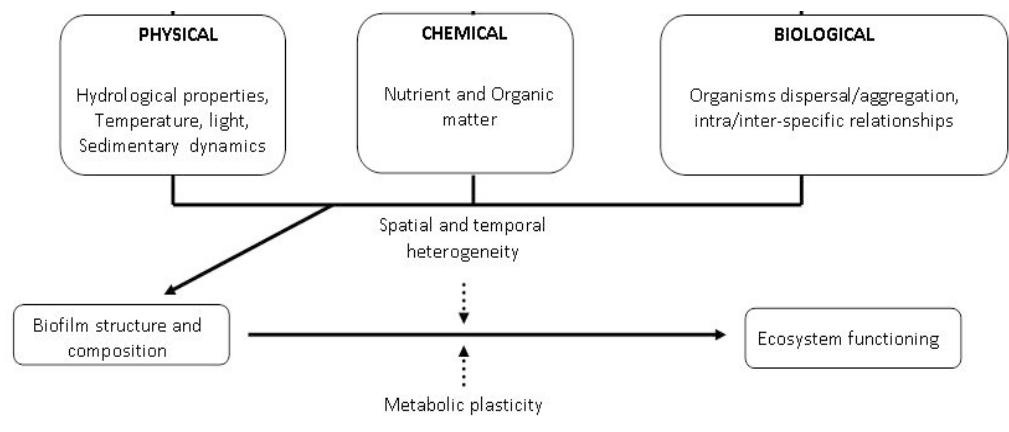
Figure 1. Physical, chemical and biological drivers affecting marine biofilms.